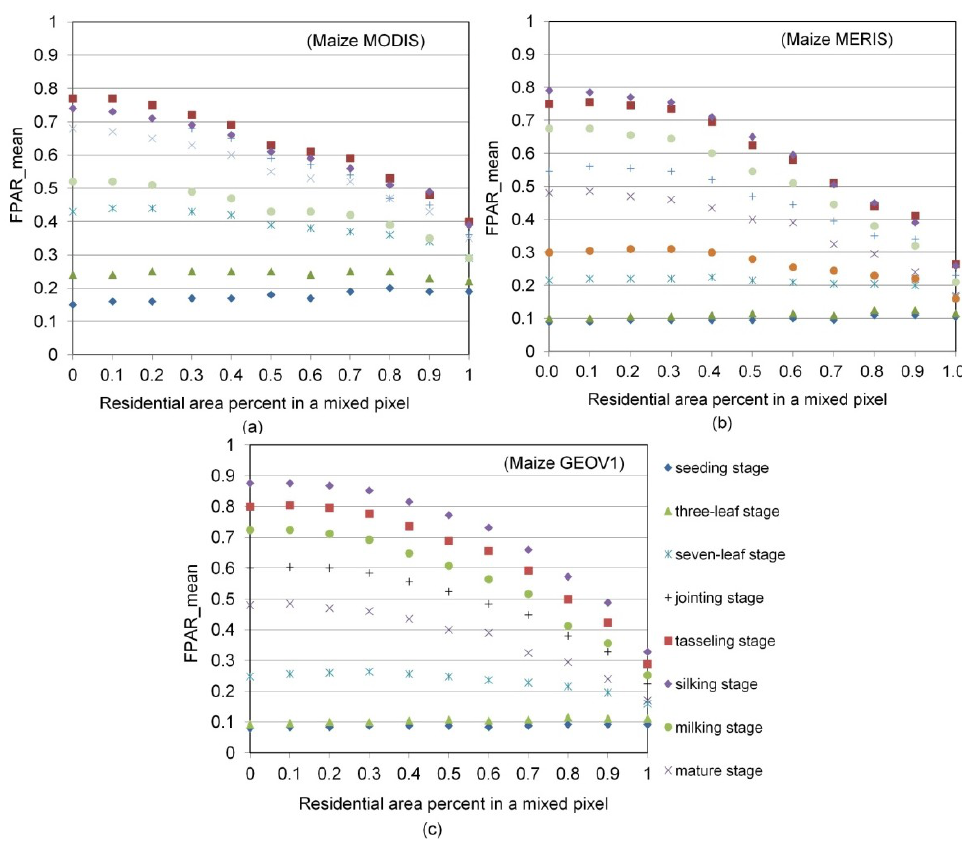
Figure 6. The changes of maize ( a ) MODIS; ( b ) MERIS; ( c ) GEOV1 FPAR in mixed pixel with residential area at different growth